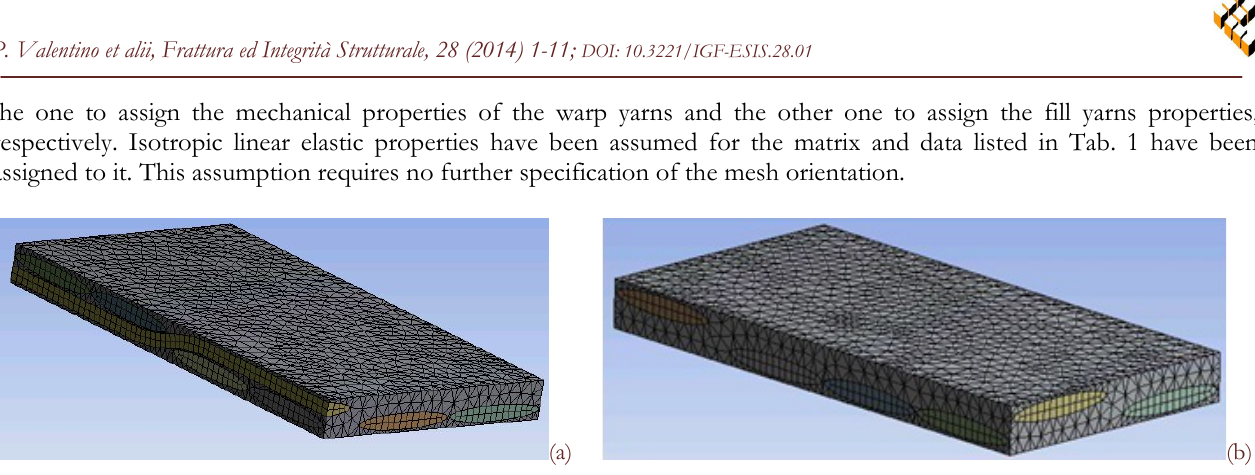
Figure 7: FE models of the RVEs (a) Twill weave 2/2; (b) Twill weave 1/3.